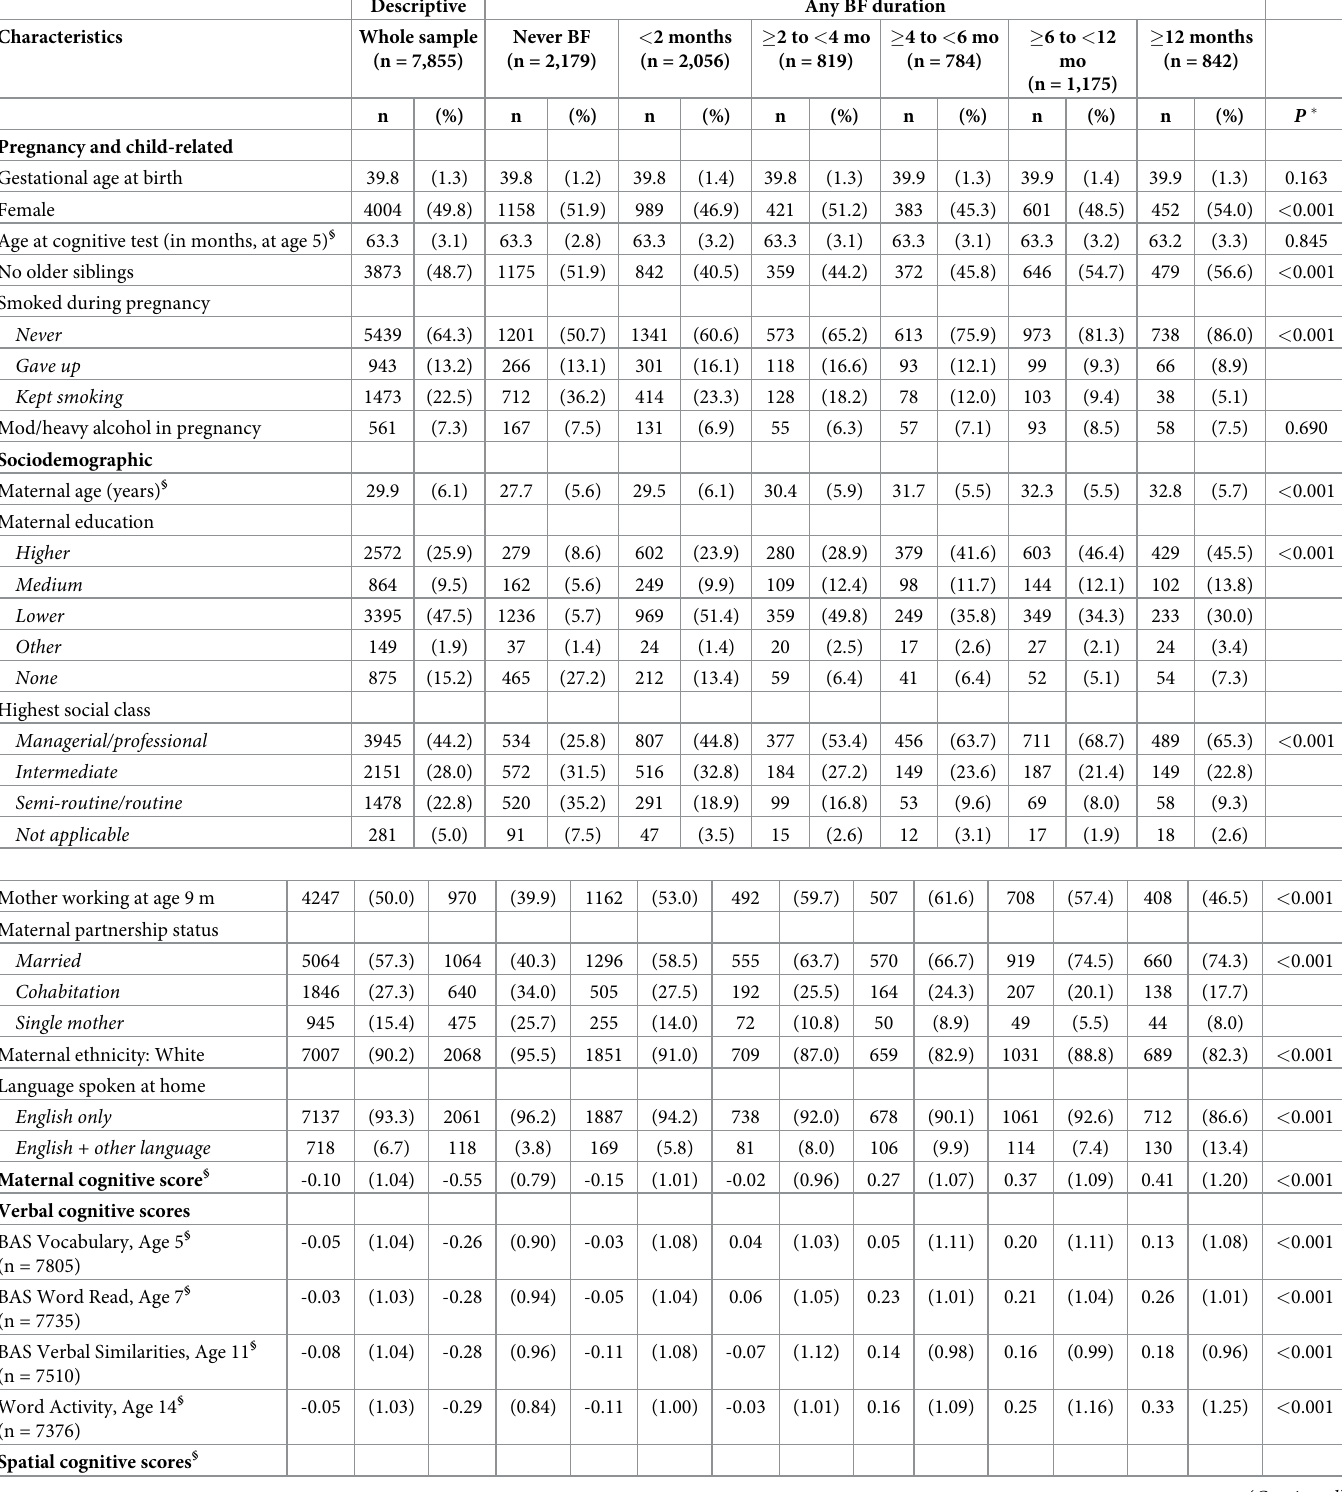
Table 1. Characteristics of the participants according to BF duration, UK Millennium Cohort Study (n = 7,855).